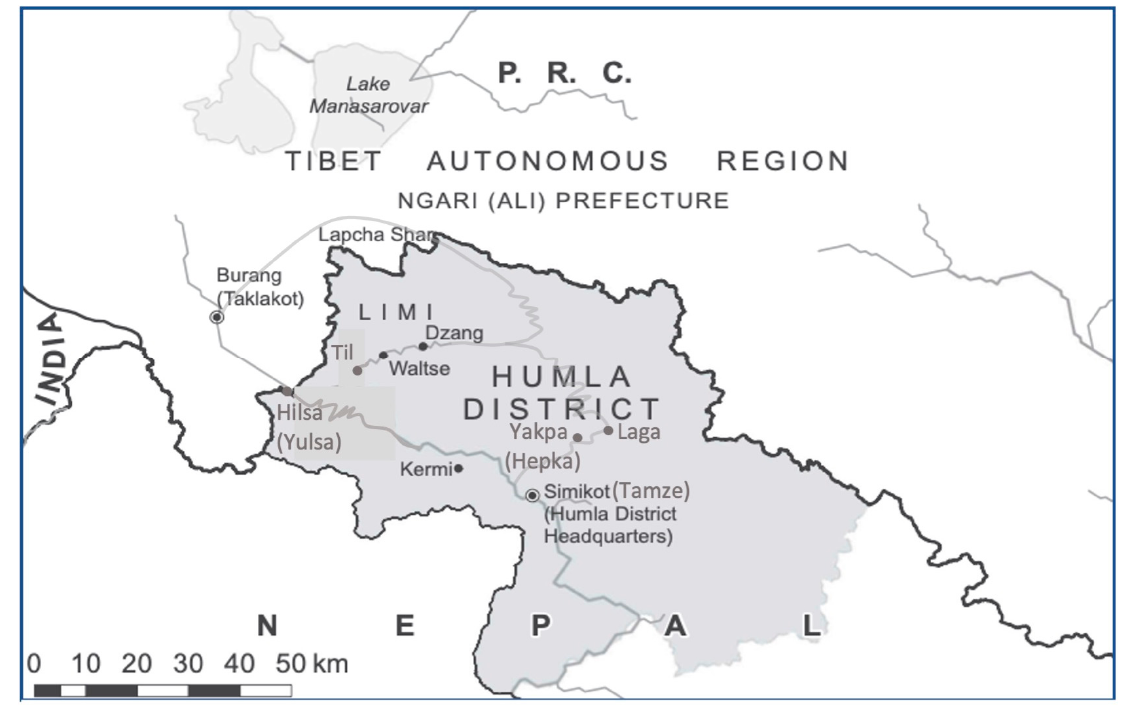
Figure 2. Limi in Humla District. Digital cartography by Mark Henderson, updated by the author. (Village names are provided in the language most spoken in each, with their Tibetan or Nepali equivalent into